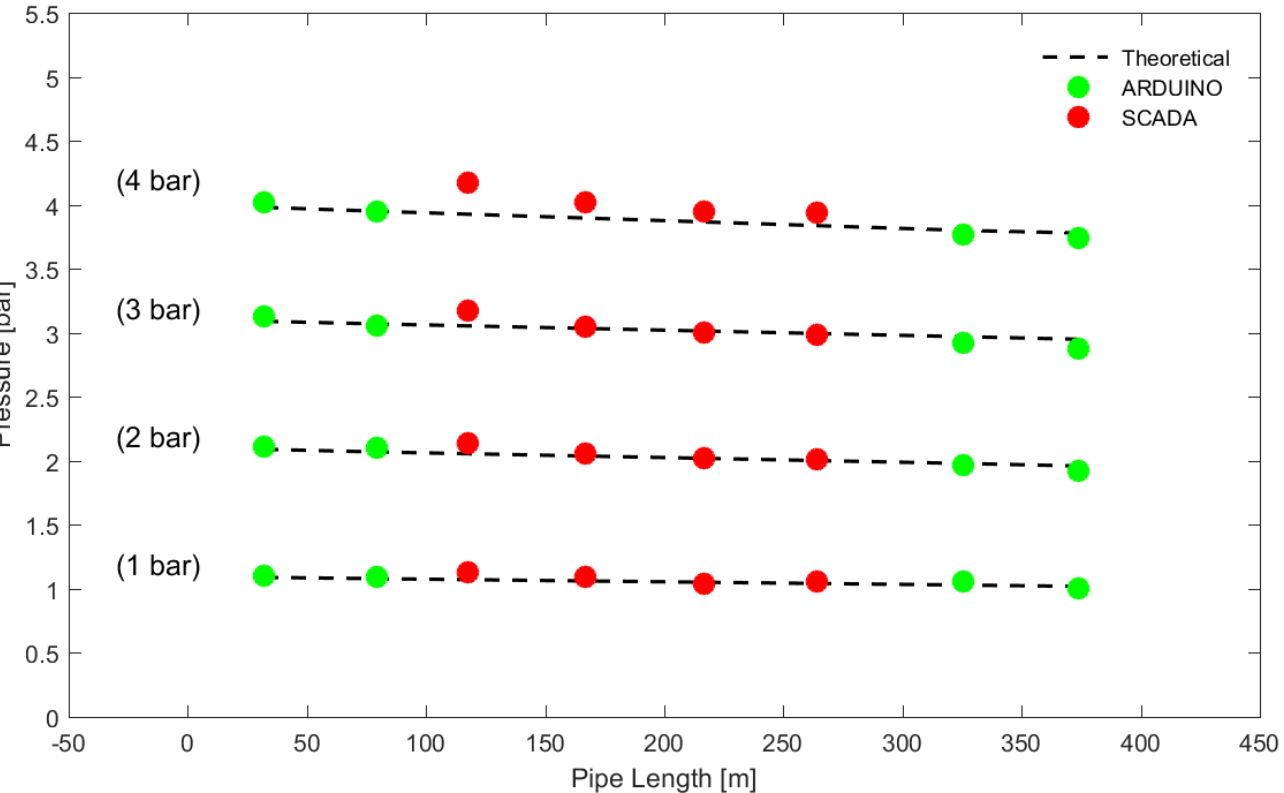
Figure 9. Piezometric line. Red bullets: SCADA data; green bullets: Arduino data; dashed line: numerical piezometric